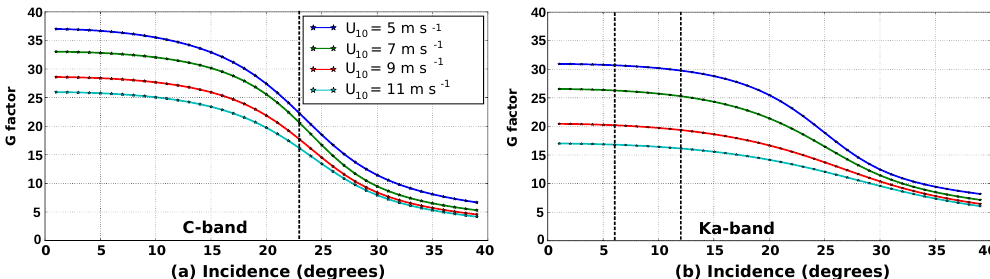
Figure 3. G factor in the upwind looking direction estimated using a Kirchhoff approximation for a wave spectrum given by Elfouhaily et al. (1997), representing a fully developed sea state for wind speeds U 10 ranging from 5 to 11ms − 1 . (a) C-band, appropriate for Envisat and Sentinel 1, (b) Ka-band for SKIM. The vertical dashed lines show the incidence angles of the instruments.